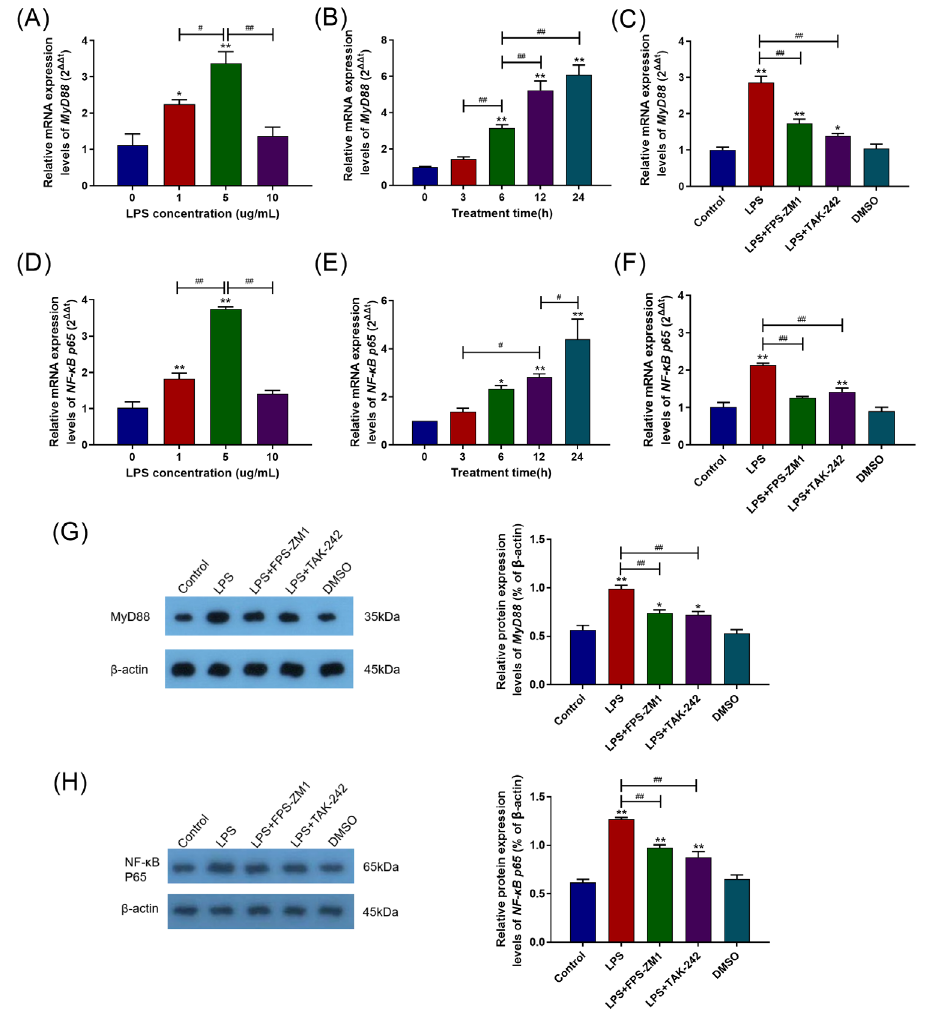
Figure 3. RAGE and TLR4 synergistically activated the MyD88 / NF- κ B signaling pathway in the inflammation caused by LPS. ( A , D ) Effects of different LPS concentrations (0, 1, 5, and 10 µ g/mL) on the levels of MyD88 and NF- κ B p65 mRNA expression. ( B , E ) Effects of different LPS treatment times (0, 3, 6, 12, and 24 h) on the levels of MyD88 and NF- κ B p65 mRNA expression. ( C , F ) Effects of FPS-ZM1 and TAK-242 pretreatment on the levels of MyD88 and NF- κ B p65 mRNA expression. ( G , H ) Comparison of gel images and grayscale for MyD88 and NF- κ B p65 immunoblot detection. Each experiment was carried out at least three times, and the data were displayed using mean ± SD. *, p < 0.05; **, p < 0.01 vs. control group; # , p < 0.05; ## , p < 0.01 vs. other treatment groups; One-way